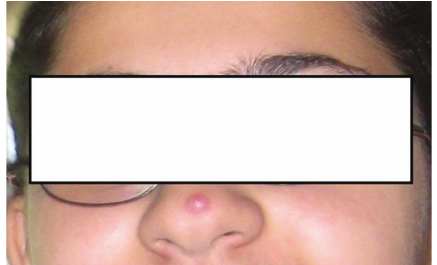
Figure 1: An 8mm firm, nonpainful nose lesion increasing in size over the span of one year.